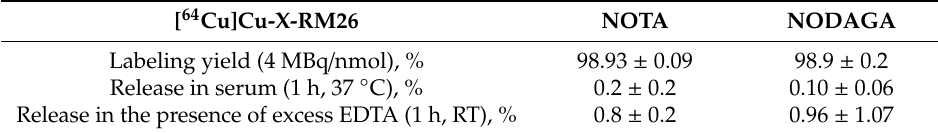
Table 1. Labeling and stability of [ 64 Cu]Cu-X-RM26 (X = NOTA-PEG 2 , NODAGA-PEG 2 ). Stability was checked in serum samples after 1 h incubation at 37 °C and in the presence of 1000× excess of ethylenediaminetetraacetic acid (EDTA) after 1 h incubation at RT. Data are presented as average ± standard deviation.